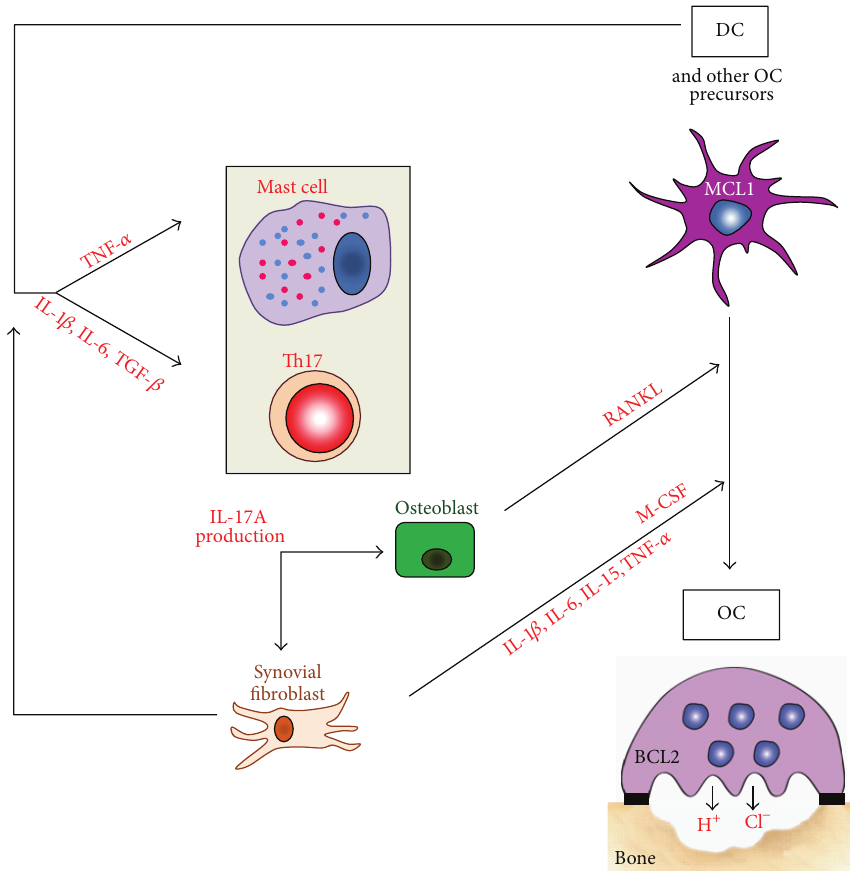
Figure 4: Pro-inflammatory cytokines drive boneresorption in rheumatoid arthritis. Cytokines are amongst the most important mechanisms driving bone resorption associated to inflammation mediated by M-CSF, RANKL, TNF- 𝛼 , IL-1- 𝛽 , IL-6, and finally IL-17A. In RA, IL- 17A is mainly produced by Th17 and mastocytes, further amplifying inflammation by enhancing pro-inflammatory cytokine production of synovial fibroblast. IL-17A also increases bone resorption by inducing RANKL production by osteoblasts and M-CSF production by synovial fibroblasts; M-CSF and RANKL are the two cytokines required to differentiate OC from different cell sources: DC, monocytes, macrophages, or bone-marrow